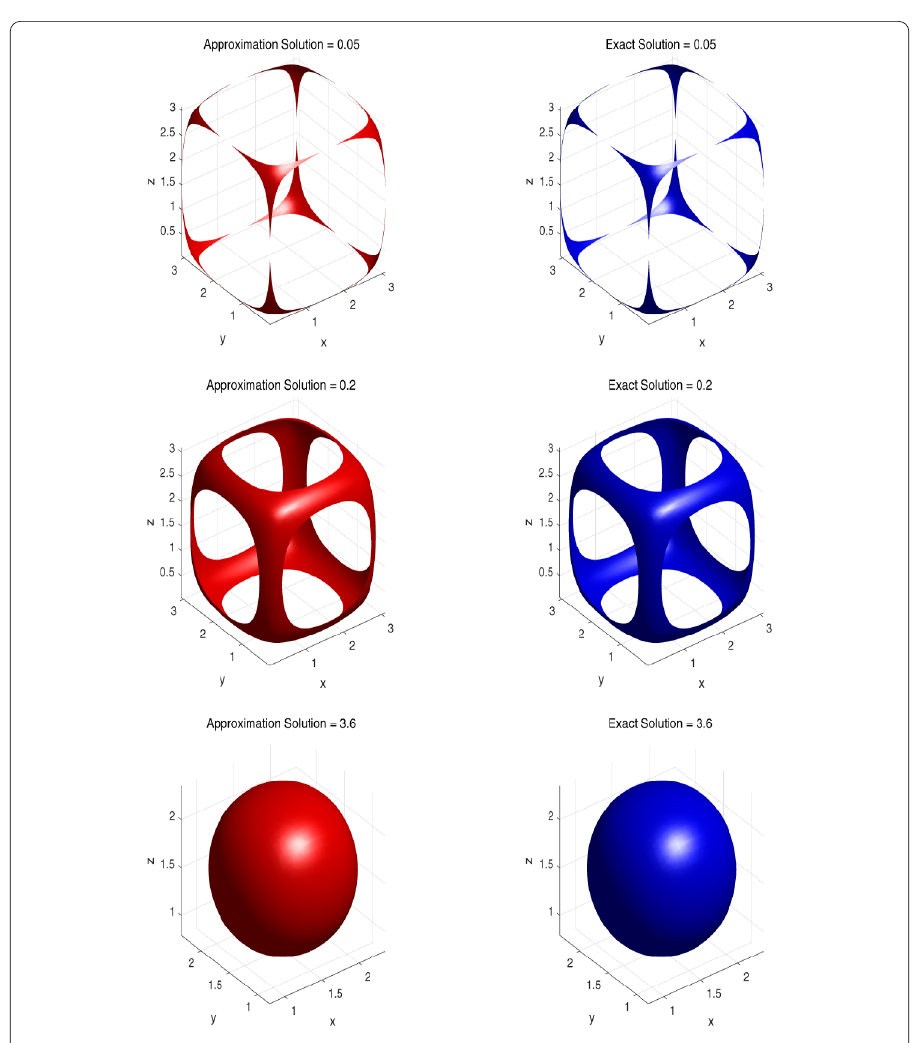
Figure 3 The graphs of isosurfaces for the approximation solution (red) and exact solution (blue) with different isovalues by scheme (59)–(61) (Example 2) Table 5 Errors and convergence orders of scheme (59)–(61) and scheme (62)–(64) in the temporal